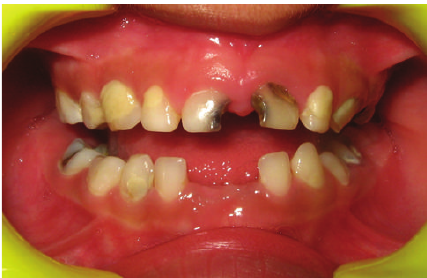
Figure 1: Preoperative condition.